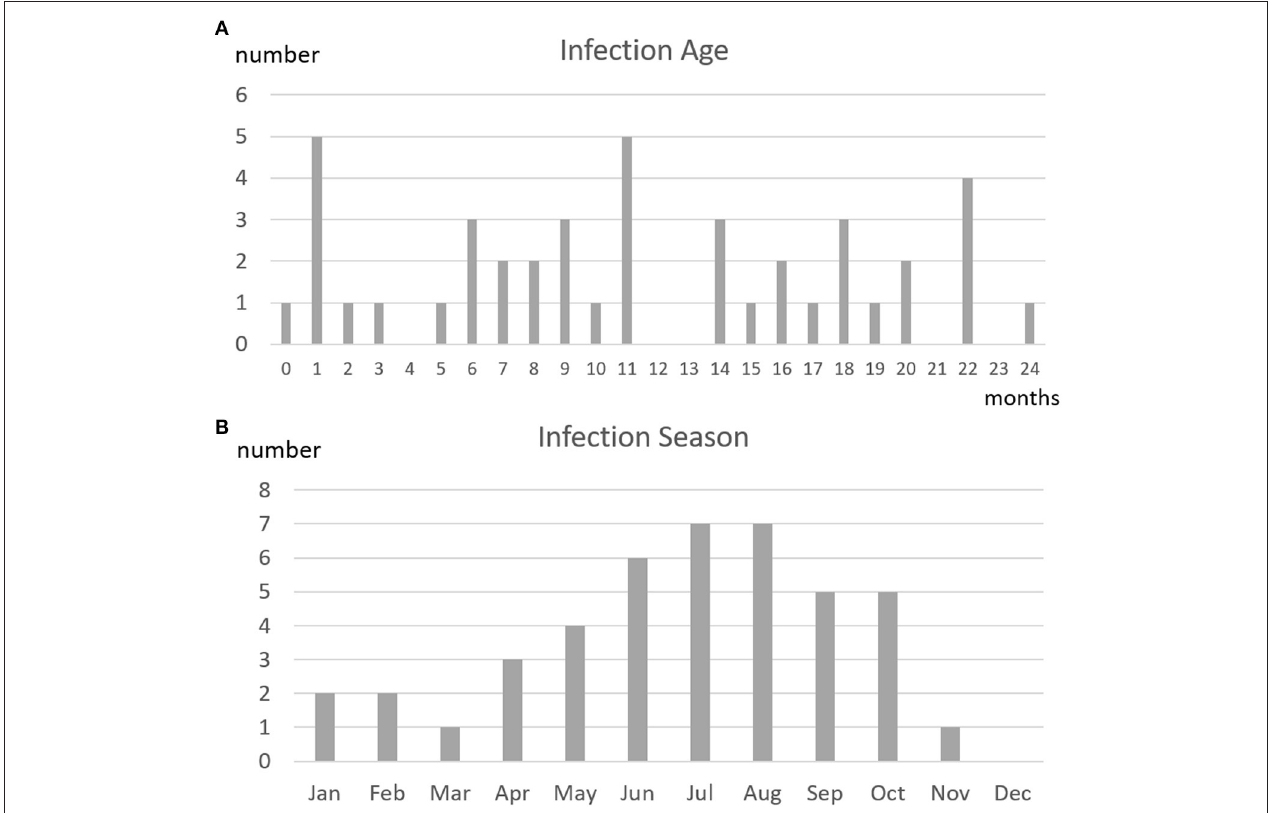
FIGURE 3 | (A) Age at infection and (B) season of infection in 42 patients with CHD treated according to the subtropical guidelines on palivizumab prophylaxis who had 43 episodes of RSV-related hospitalizations. The distribution of ages at infection did not identify a high-risk age group. The graph showing the times of occurrence of RSV infections did not reveal RSV